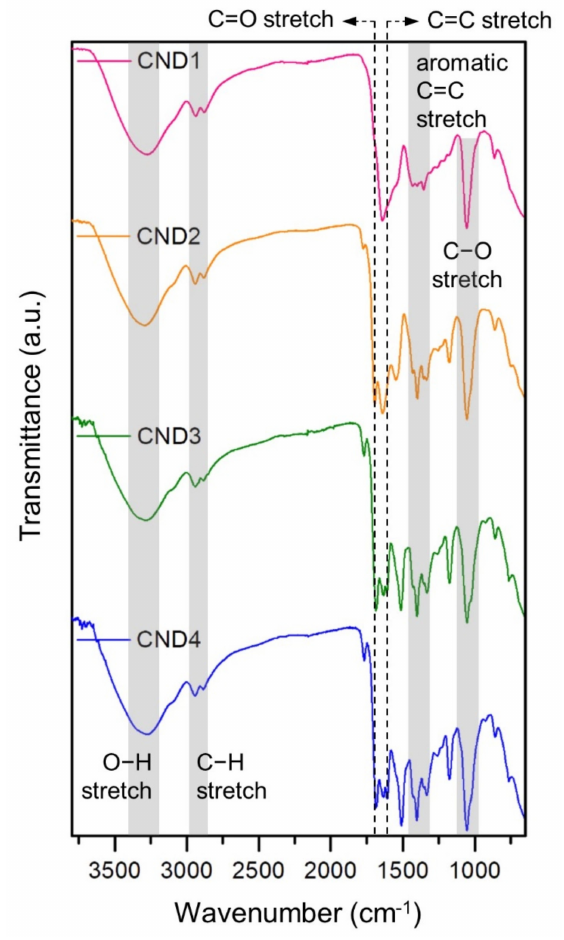
Figure 2. FT-IR spectra of the CNDs. The C=O (1693 cm − 1 ) and C=C (1640 cm − 1 ) stretch peaks are indicated by the dotted vertical